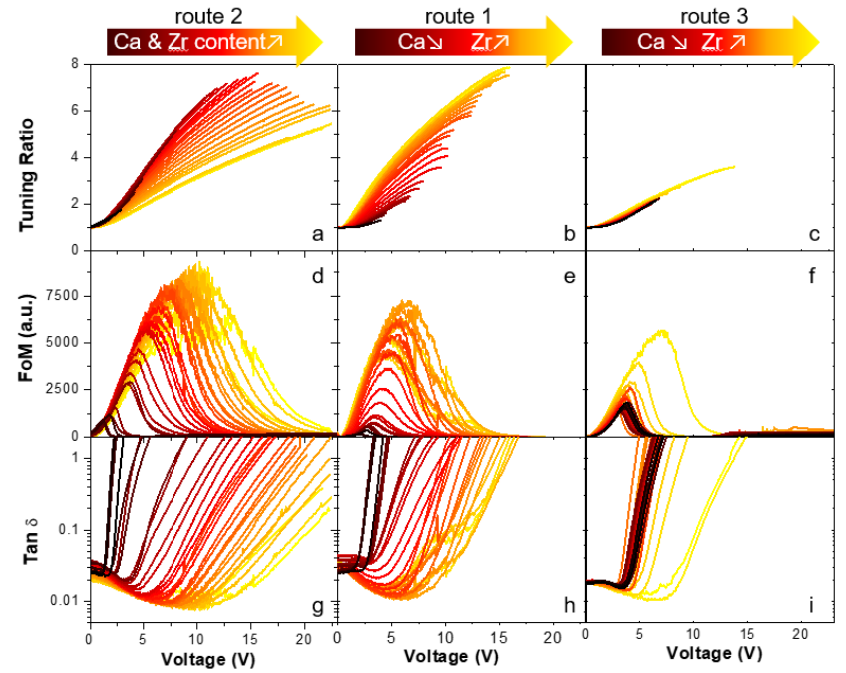
Figure 5. Tuning ratio ( a – c ), FOM ( d – f ) and Tan δ ( g – i ) vs. applied dc voltage for varying Ca and Zr content along route 2 (BTO-BCTZ), route 1 (BCT-BZT) and route 3 (BCTZ-BCT).